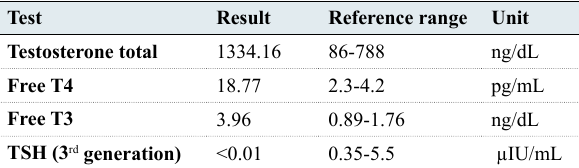
Table1: Laboratory finding of TFT and total testosterone